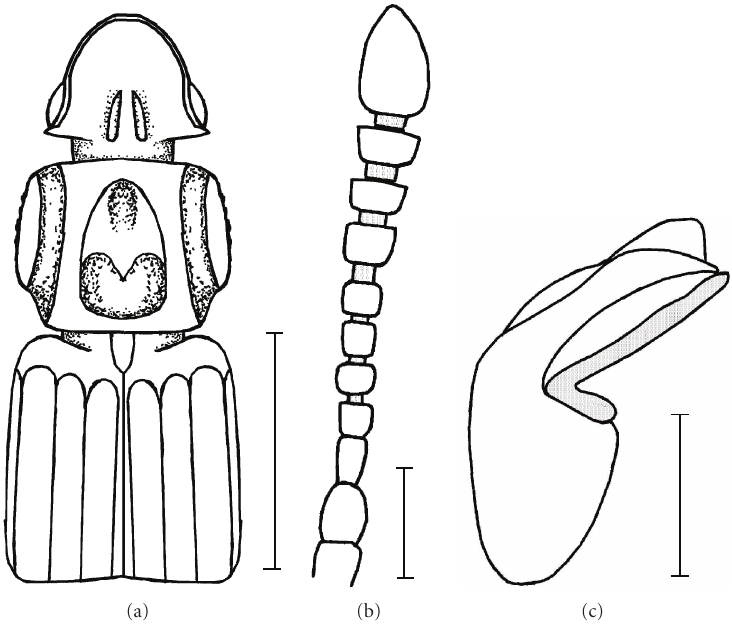
Figure 3: Fore body (a), antenna (b), and aedeagus (c) of T. silvaticus (scale bar (a) 0.5mm, ((b and c) 0.1mm).